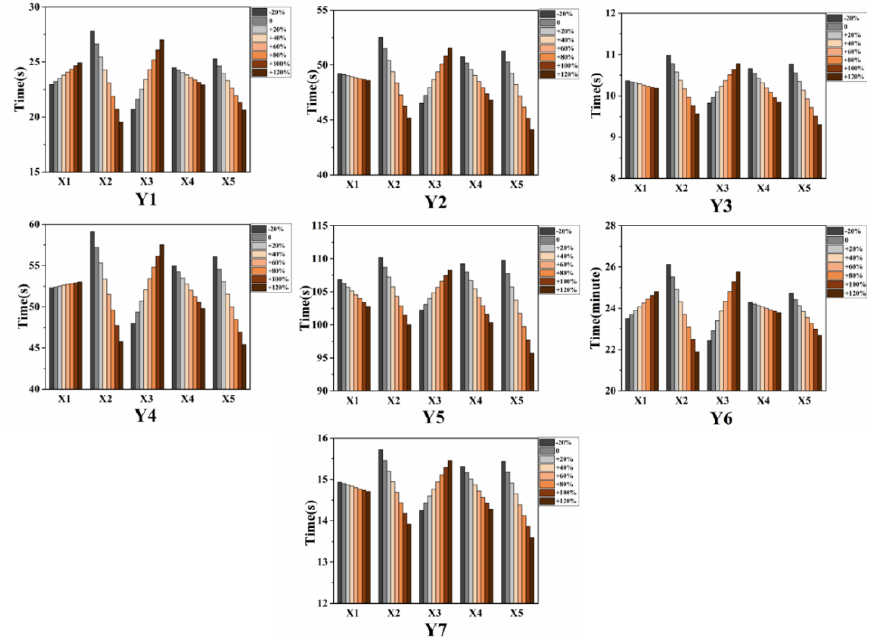
Figure 2. The predicted results of the response variables base on the PLSR model. Y1: the predicted results of the performance of rope climb; Y2: the predicted results of the performance of run 200 m round trip with load; Y3: the predicted results of the performance of run 60 m carrying a ladder; Y4: the predicted results of the performance of climb stairs with a load. Y5: the predicted results of the performance of evacuation of 400 m with supplies; Y6: the predicted results of the performance of run 5 km with an air respirator; Y7: the predicted results of the performance of run 100 m with the water hose.